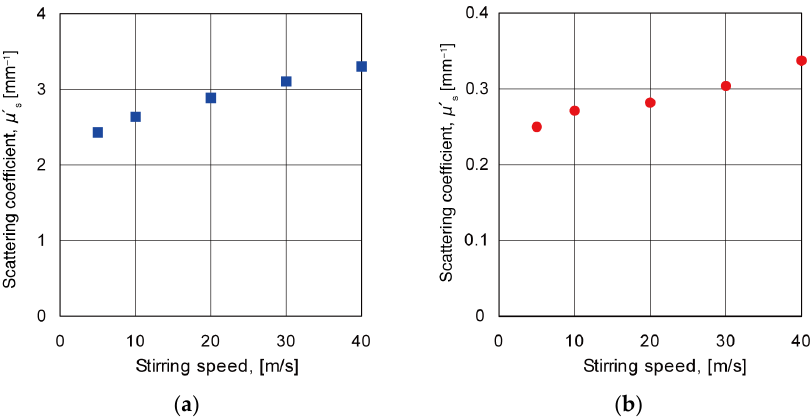
Figure 7. Scattering coefficients at different stirring speeds: ( a ) titanium dioxide sample (Nos. 1–5) and ( b ) zinc oxide sample (Nos. 6–10).